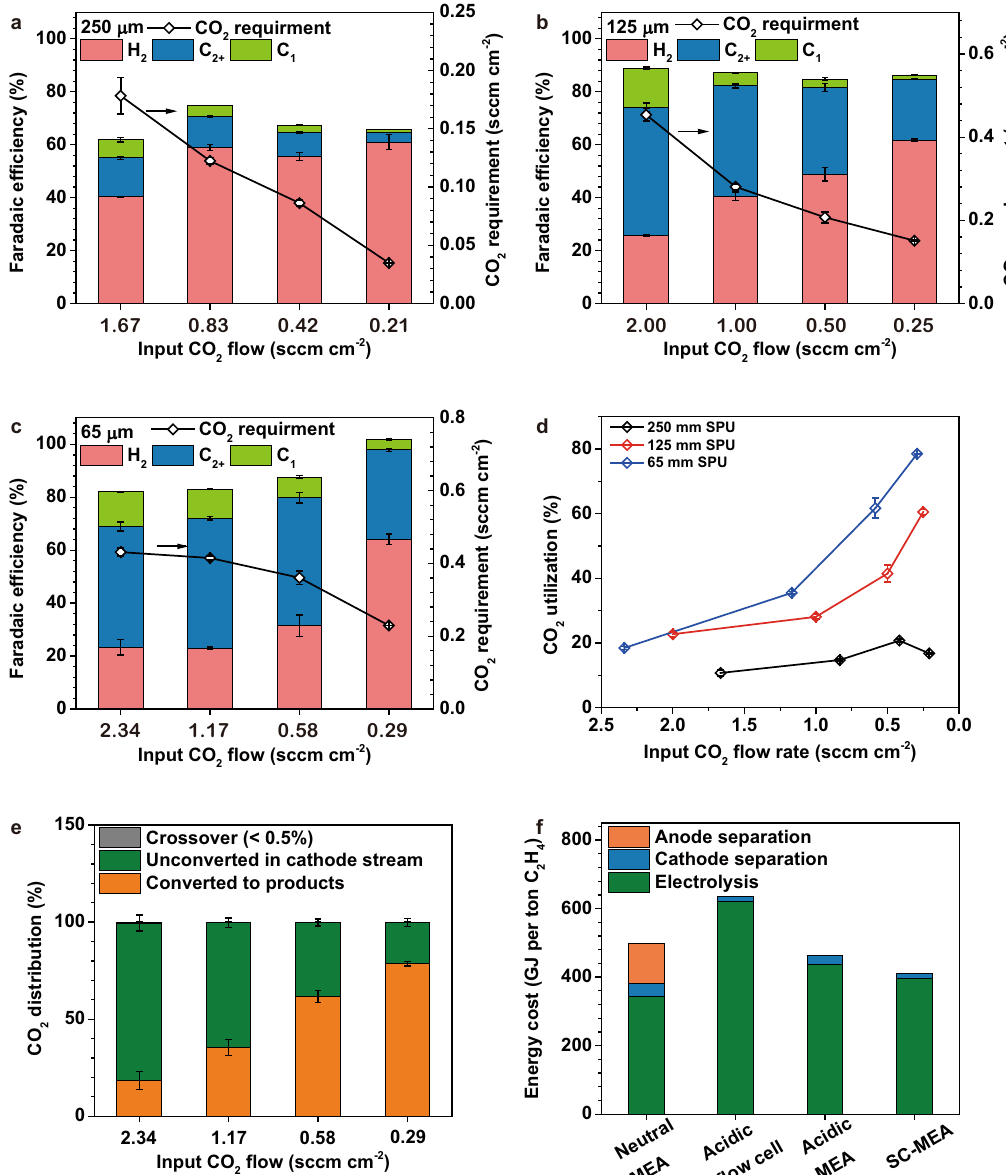
Fig. 4 The exploration of the CO 2 RR performance and energy intensity of SC-BPMEA with restricted reactant availability. All the measurements were conducted at 35 °C and 200 mA cm − 2 , and the data were collected after 2 h of continuous operation. a – c The FE distributions and the CO 2 requirements (total CO 2 converted to products) of the SC-BPMEAs with different catholyte thickness and input CO 2 fl ow rates (sccm normalized by electrode area). C 1 refers to CO, formate, and methane. C 2 + refers to ethylene, ethanol, acetate, and n-propanol. d The total CO 2 single-pass utilization (the CO 2 -to-ethylene single-pass conversion see Supplementary Fig. 13a) for the SC-BPMEAs with different catholyte thickness and input CO 2 fl ow rates. e Carbon balance in SC-BPMEA with 65 μ m 0.5 M K 2 SO 4 at different input CO 2 fl ow rates. See Supplementary Fig. 13b for plots on a logarithmic scale. f The comparison of the energy cost distributions among state-of-art CO 2 -to-ethylene electrolyzers. The SC-BPMEA case refers to the input CO 2 fl ow rate of 1.17 sccm cm − 2 . The error bars represent the standard deviation of three